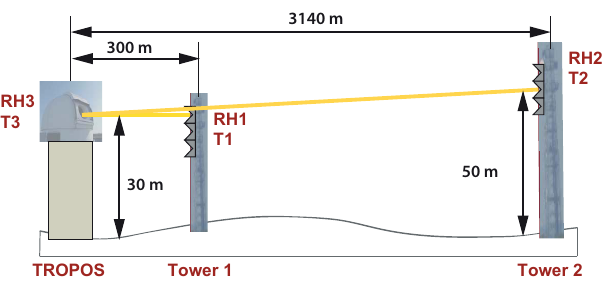
Figure 1. Sketch of the SÆMS measurement configuration. A light beam is transmitted at TROPOS and direct to a retroreflector ar- ray mounted at tower 1 for several minutes. Afterwards the beam is moved to the second retroreflector array at tower 2 for several minutes, followed by the next round in which the beam is again di- rected to tower 1, and so on. Particle extinction is derived from the tower 1 and tower 2 long-path transmission observations, and thus is related to an almost horizontal path of 2840m at a height of 30– 50m above ground. The aerosol particle extinction measurements are set into context with meteorological observations of tempera- ture ( T ) and relative humidity (RH), which are measured at the roof of TROPOS (T3, RH3) and close to the retroreflectors at tower 1 (RH1, T1) and tower 2 (RH2,